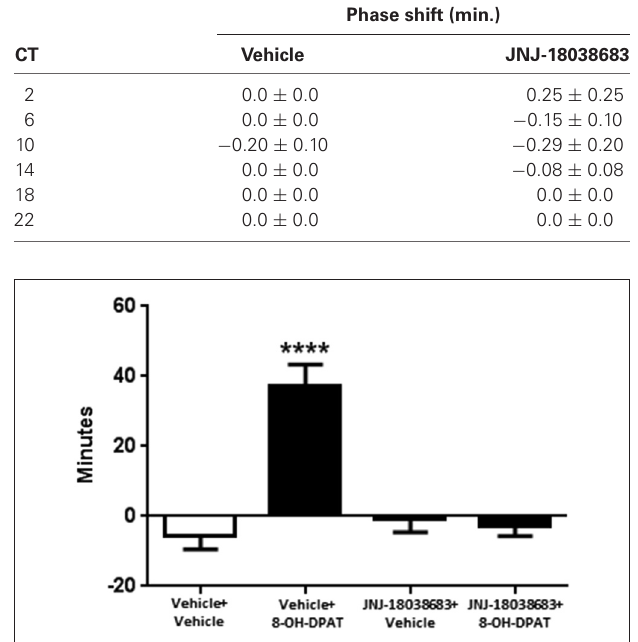
FIGURE 1 | Phase shifting effects of JNJ-18038683 (3 mg/kg. i.p.) and 8-OH-DPAT (3 mg/kg, i.p.) on the circadian rhythms of wheel running activity in mice . Mice were randomly divided to receive one of four treatments: Vehicle + Vehicle ( n = 14), Vehicle + 8-OH-DPAT ( n = 21), JNJ-18038683 + Vehicle ( n = 11), and JNJ-18038683 + 8-OH-DPAT ( n = 16). After treatment, phase shifts of locomotor activity were calculated based upon the onset of activity following treatment compared to prior treatment. Results are expressed as mean ± S.E.M. and a one-way ANOVA followed by a Tukey’s post hoc test was performed to determine if a result was significant (**** p < 0.0001 vs. Vehicle + Vehicle, JNJ-18038683 + Vehicle, and JNJ-18038683 +